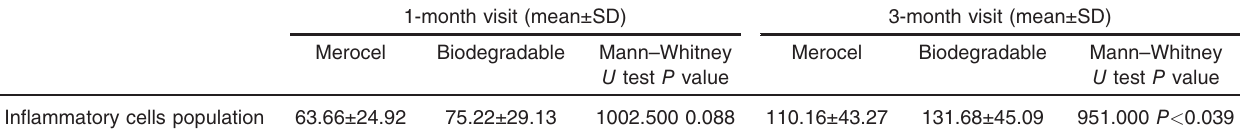
Table 4 Comparison between biodegradable and nondegradable sides regarding the inflammatory cellular infiltration at 1- and 3- month postoperatively